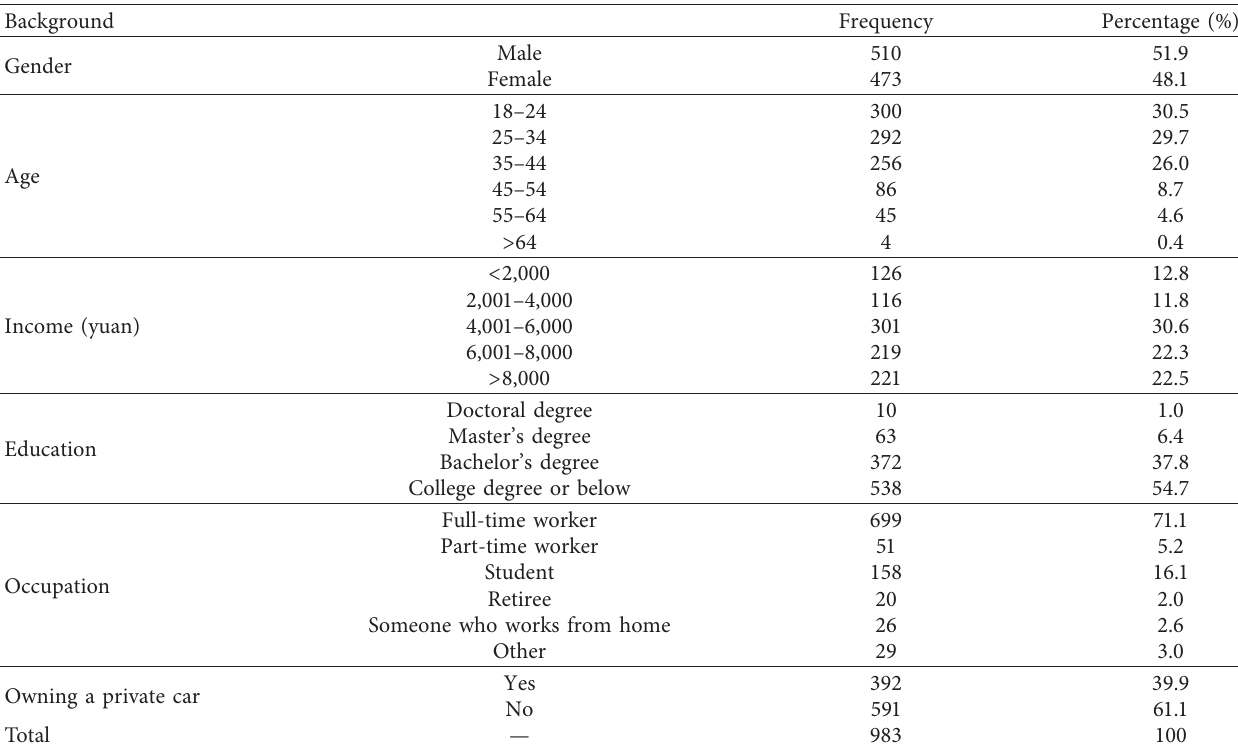
Table 1: Summary